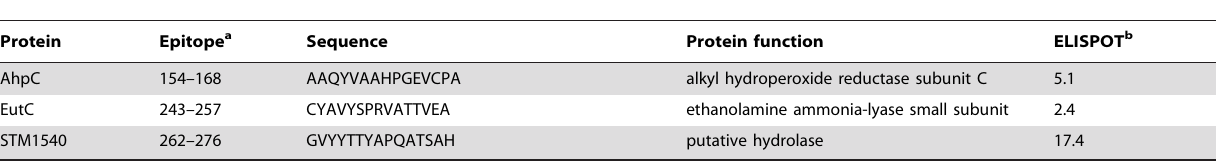
Table 1. CD4 + T cell epitopes to virulent Salmonella